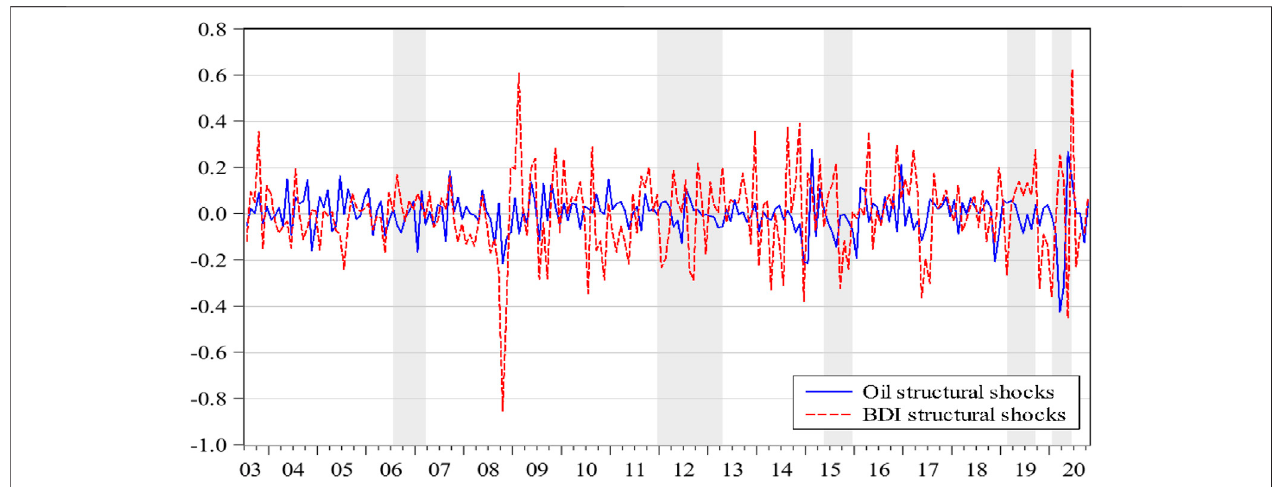
FIGURE 3 | Dynamic feature recognition of oil commodity attribute. Note: Shadow parts show negative relationship between the structural shocks of oil demand and oil price.